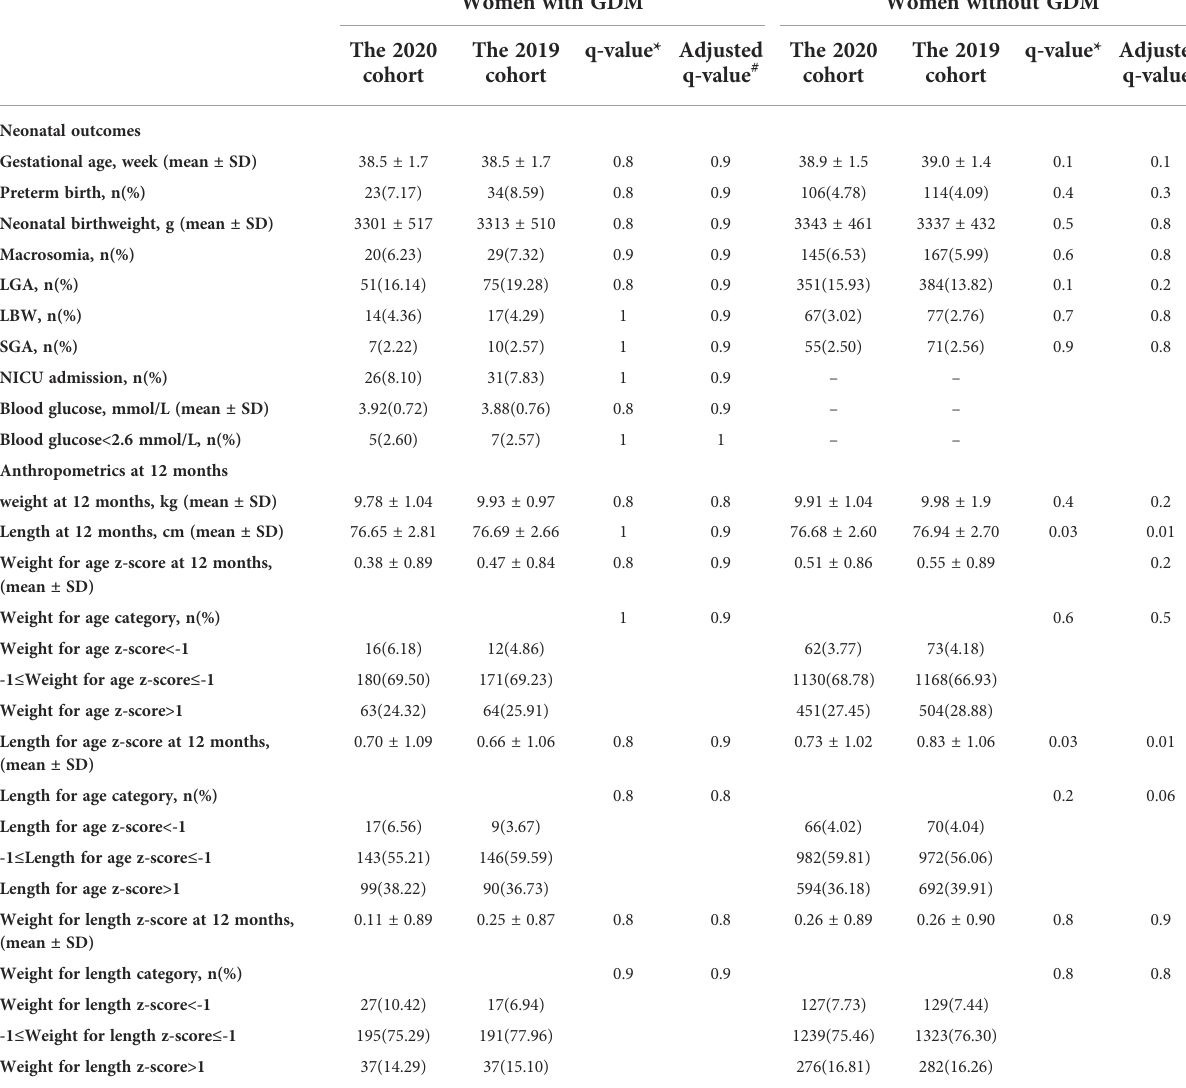
TABLE 5 Comparison of offspring outcomes between 2019 and 2020